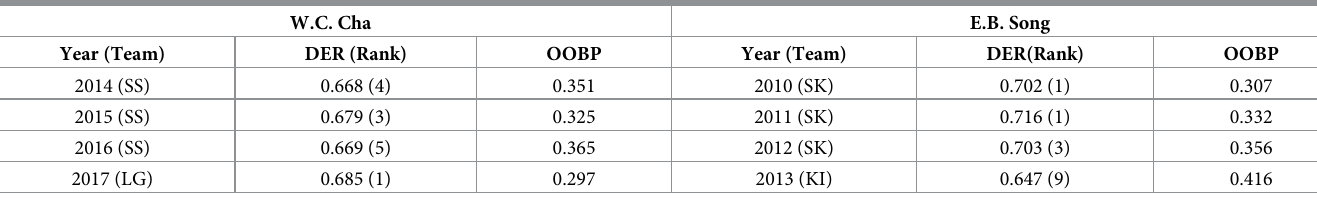
Table 4. OOBP changes of two pitchers according to